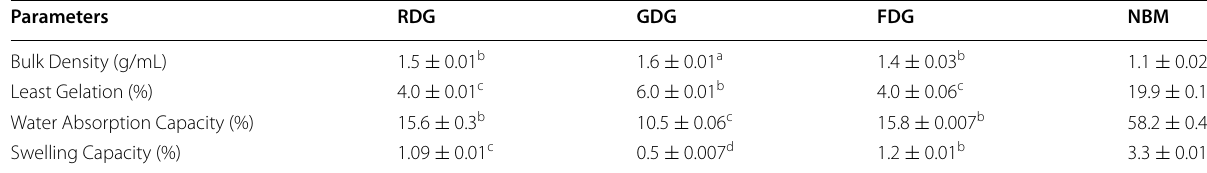
RDG Raw maize, defatted groundnut and ginger in ratio 76.7:20.8:2.5 GDG Germinated maize, defatted groundnut and ginger in ratio 74.4:23.1:2.5 FDG Fermented maize, defatted groundnut and ginger in ratio 72.6:24.9:2.5 NBM Nutribom (a commercial maize-based complementary food) a, b, c, d Means ( SEM) with different alphabetical superscripts in the same row are significantly different at P < 0.05 ±